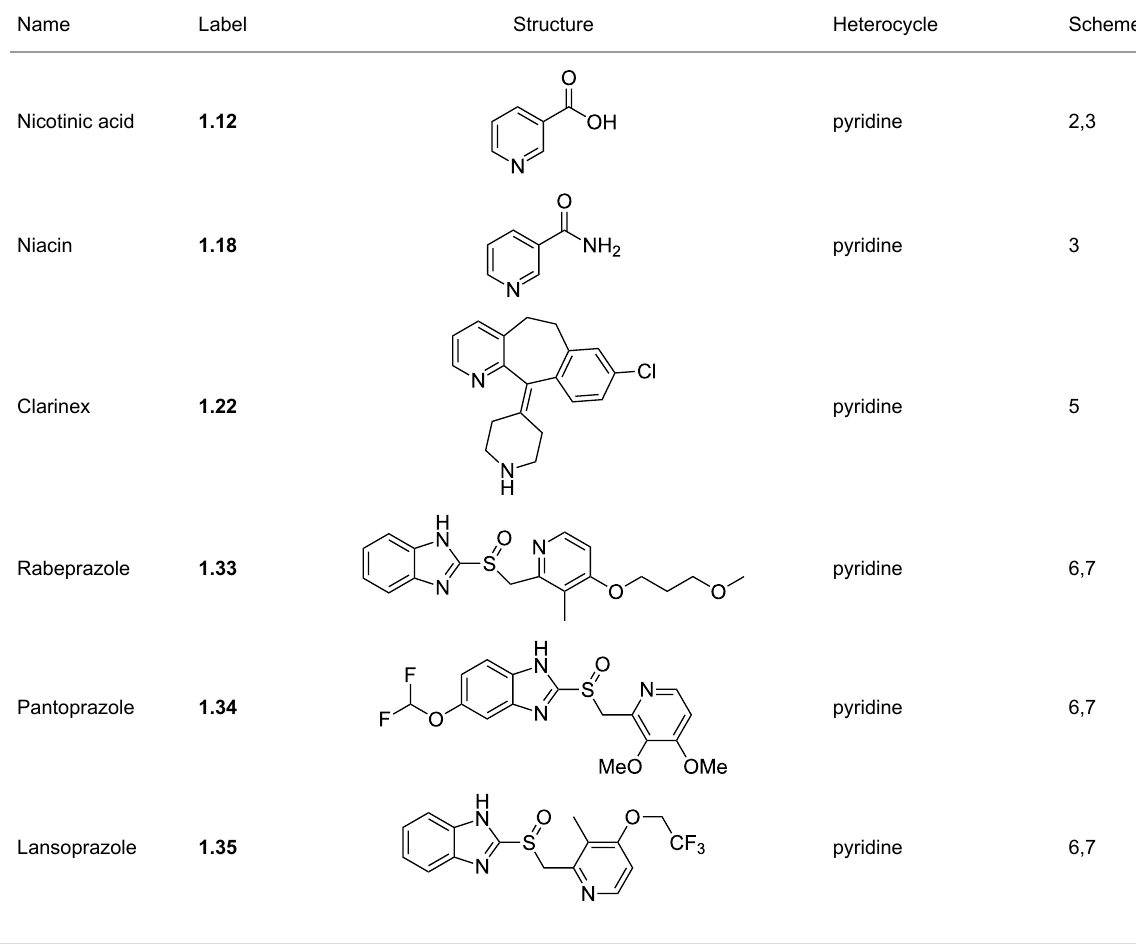
Table 1: Chemical structures of the heterocyclic compounds discussed in this